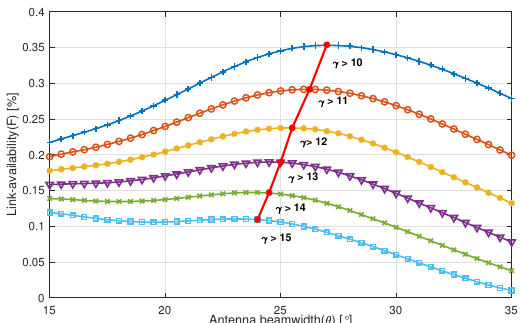
Figure 11. An example of SINR vs antenna beamwidth with different SINR threshold. The red line represents the optimal antenna beamwidths ( θ ∗ ) when maximum link-availability achieved.